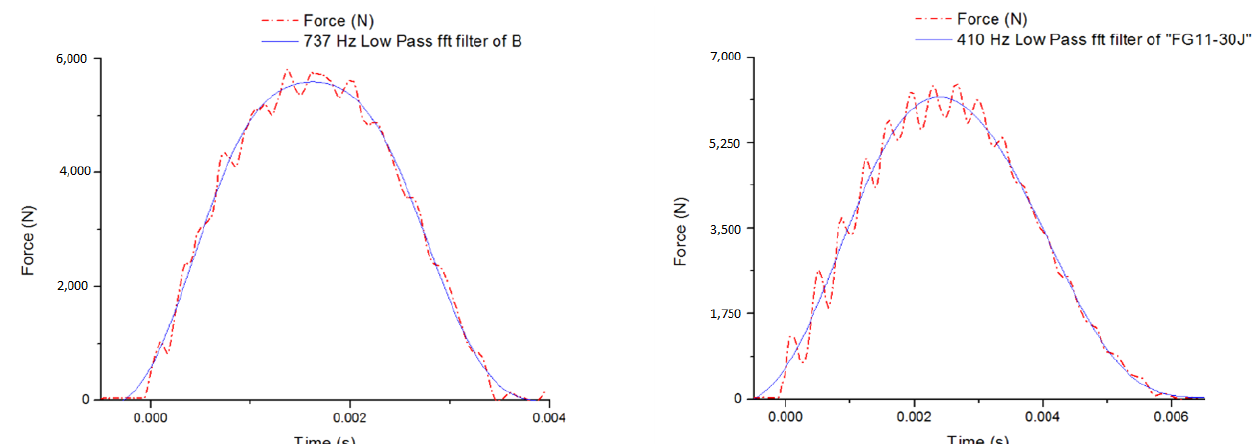
Figure 4. Comparison between the as acquired and low pass filtered curves.